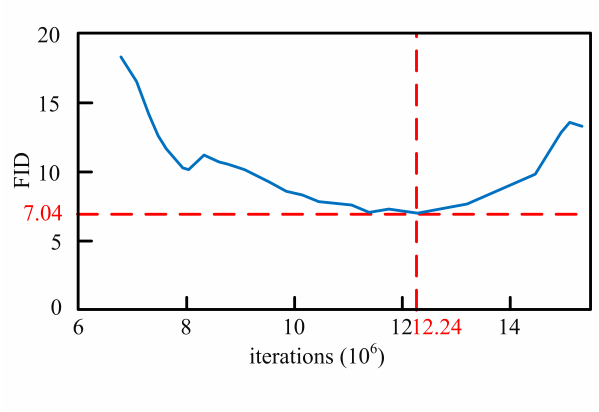
Figure 10. The FID-iterations curve of images generated by the trained model. The horizontal axis represents the number of iterations, and the vertical axis represents the FID between the distribution of generated images and the distribution of real images. It can be seen that when the number of iterations of model training reaches 12.24 million, FID reaches the minimum value of 7.04.